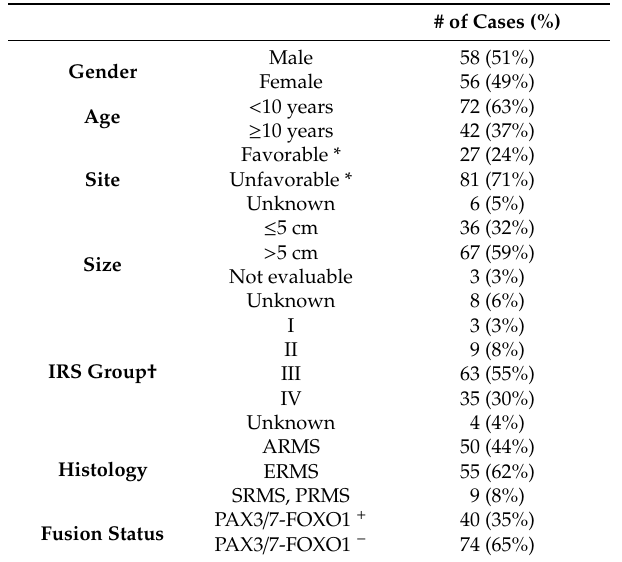
Table 1. Main clinical pathological features of 114 rhabdomyosarcoma (RMS)